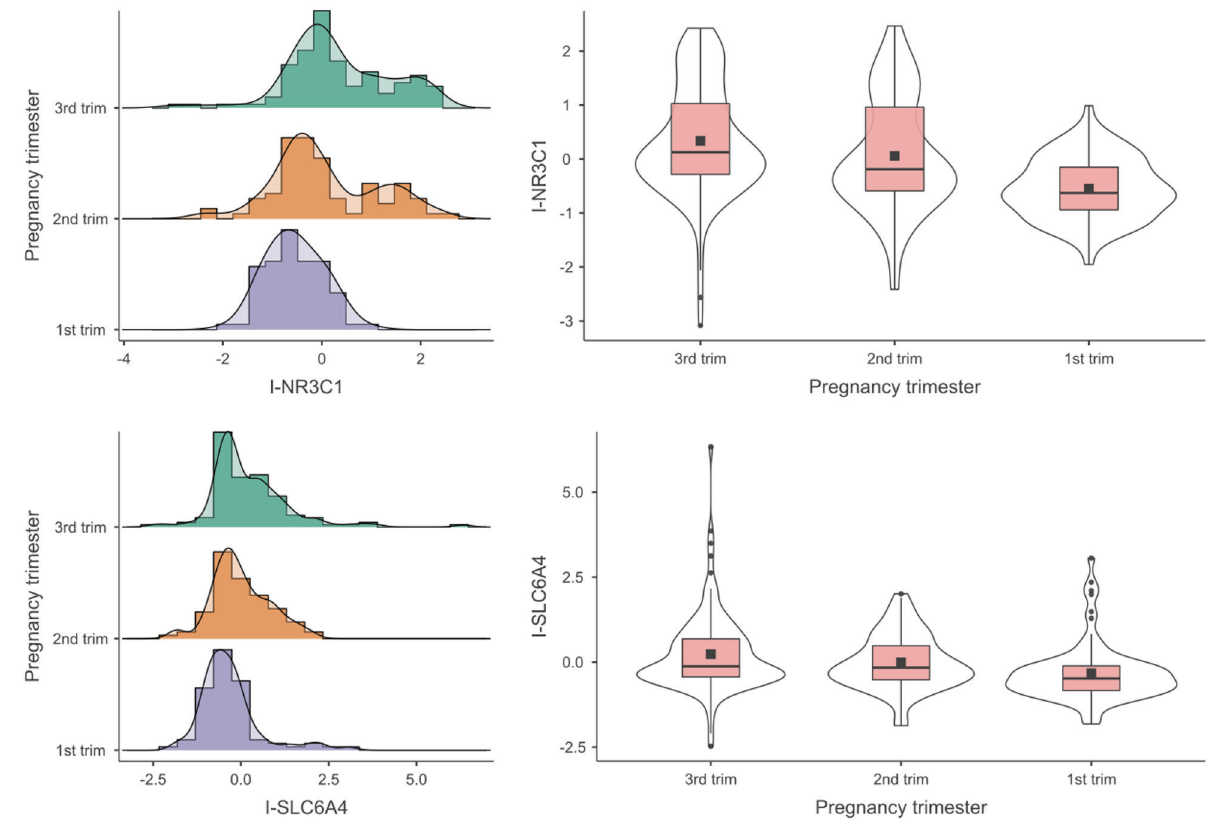
Fig. 3 Infants ’ SLC6A4 and NR3C1 methylation by pregnancy trimester. Note. *** P <